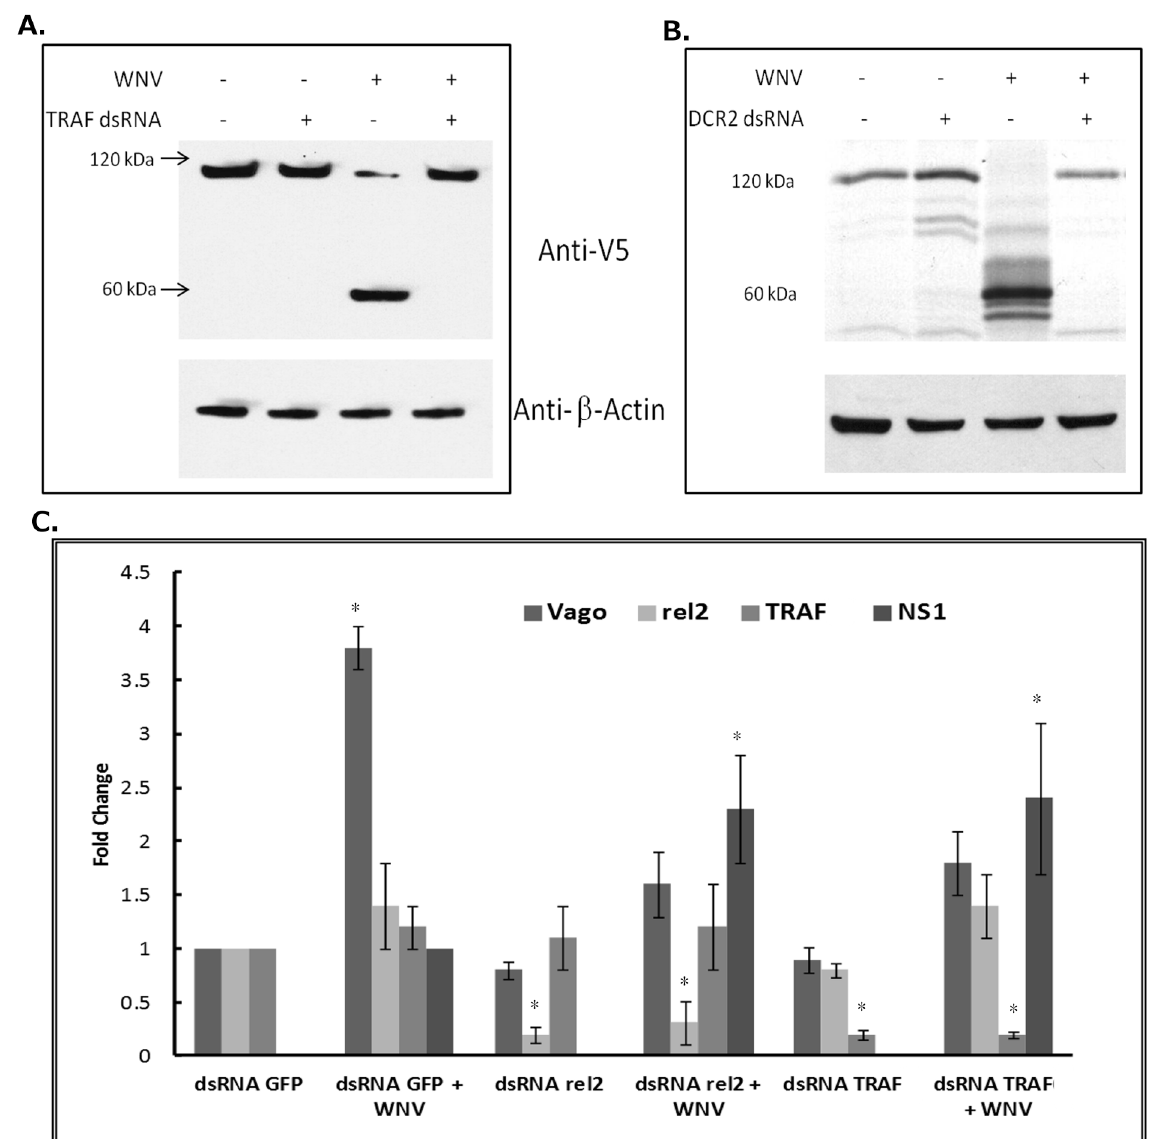
Figure 5. Cx Vago activation occurs via Dicer2-TRAF-Rel2 mediated pathway. Hsu cells were transfected with CxRel2 plasmid (with C- terminal V5 tag) and dsRNA against TRAF ( A ) or Dicer-2 ( B ). At 24 h post-transfection, the cells were infected with WNV and cell lysates was collected 48 hpi. Western blot was performed using anti-V5 and anti-beta actin antibodies. Representative blots shown here. ( C ) Female Culex mosquitoes were microinjected with dsRNAs against GFP, Rel2 or TRAF. After 48 h, the mosquitoes were infected with WNV (Kunjin strain). Total RNA was collected at 48 hpi and real-time RT-qPCR was performed using Cx Vago, Cx Rel2, Cx TRAF and WNV NS1 primers. Error bars represents standard error from experiment with assays performed in duplicates (Student’s t-test *p , 0.05 compared to dsRNA